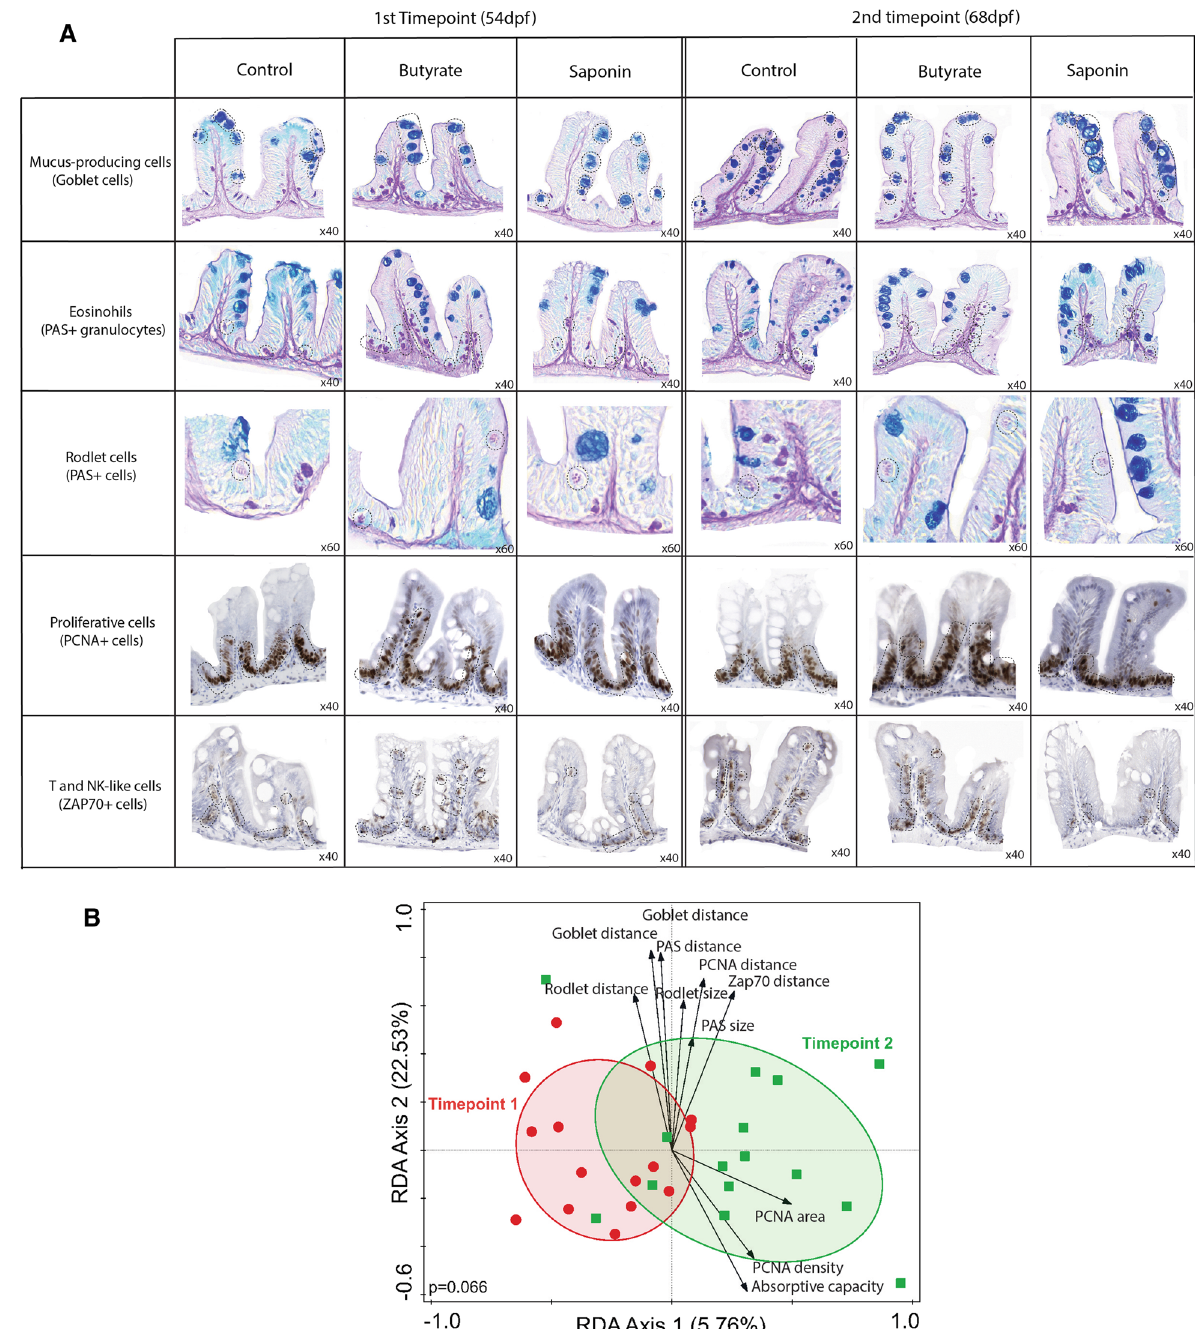
Fig. 7 High-throughput quantitative histological analysis. A Representative pictures of all cell-types analyzed for all the diets and timepoints with cells of interest in dashed black lines per each group. B Redundancy analysis to examine the effect of time on the histological parameters analyzed. The x axis separated the samples by timepoints and explained 5.76% of the variation observed. The link of time and variation of the histological parameters was not significant ( p 0.066) C Redundancy analysis to examine the effect of diet on the histological parameters analyzed. The x axis = separated the samples of butyrate fed fish from saponin and control fed fish and explained 5.86% of the variation explained. The y axis separated saponin fed fish from control fed fish and explained 5.07% of the variation observed. The link of time and variation of the histological parameters was significant ( p 0.036). The top 10 most distinctive histological parameters are depicted in black arrows. The direction of the arrows correlate = with the dietary intervention and the length of the arrows represents the strength of the correlation. The boxplots around the RDA depicted the absorptive capacity and the percentage area of cells of interest compared to the total gut area per diet and timepoint. * p 0.05, one-way ANOVA ≤ test or Kruskal–Wallis test after testing for normality on data distribution by Shapiro–Wilk test. No false discovery rate performed. Whiskers: min. to max. shall all points with